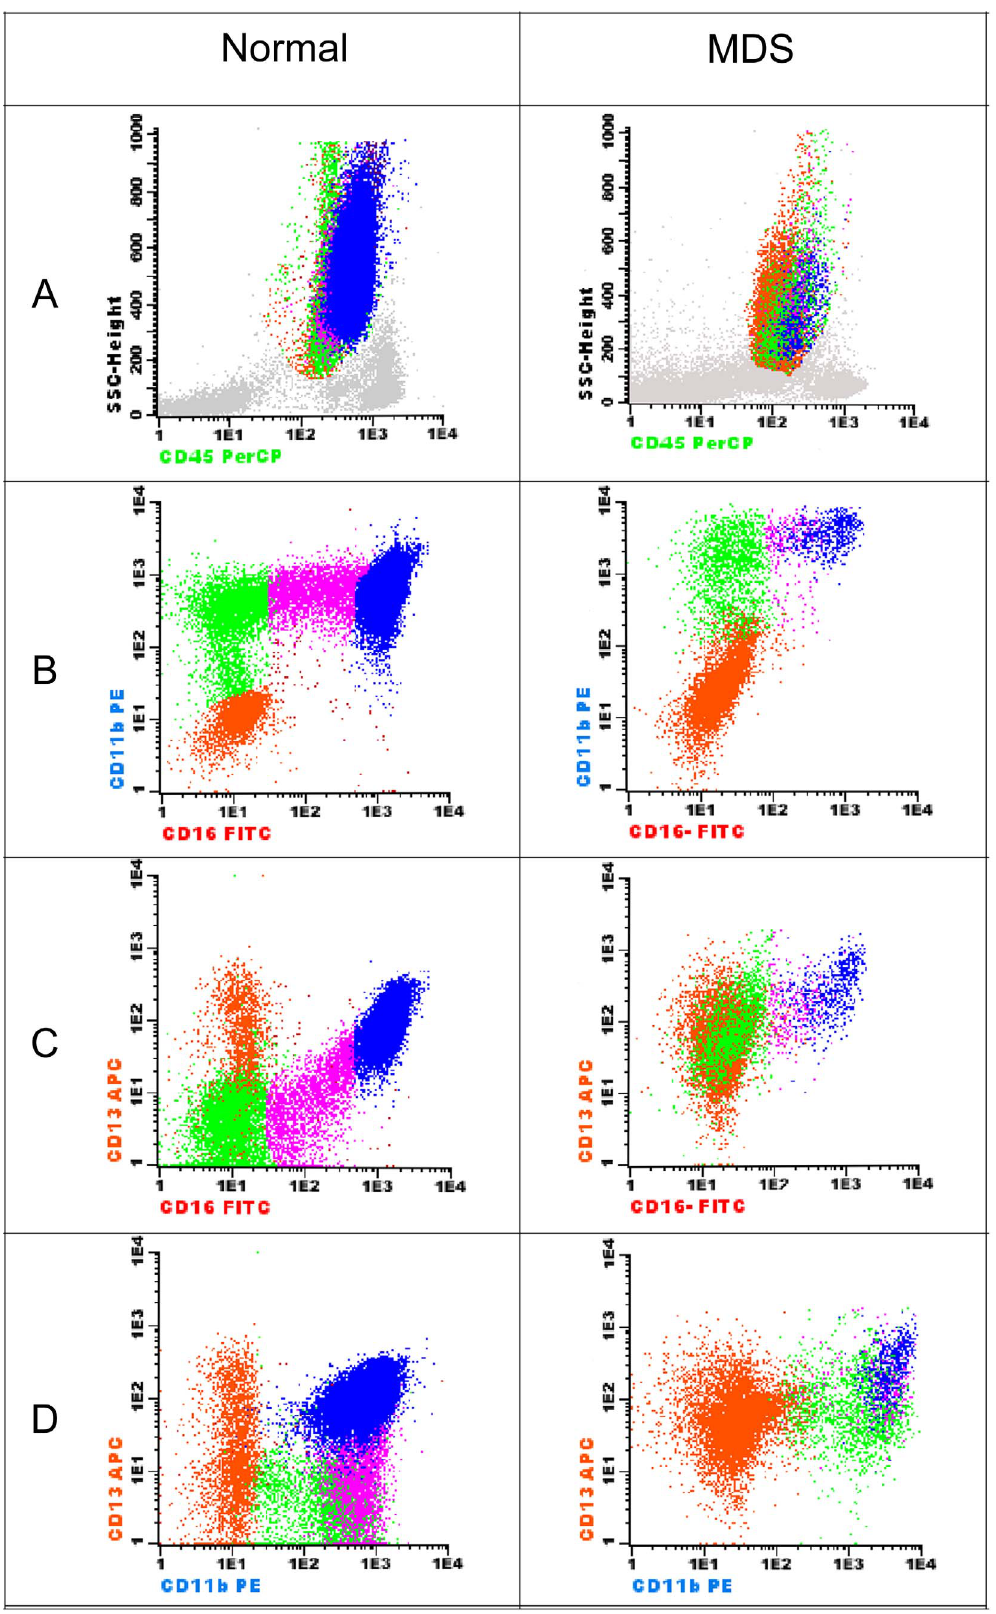
Figure 1. Detection of abnormalities in the granulocytic maturation: plots found in a normal BM on the left and those in a case of RCMD on the right (combination: CD16/CD11b/CD45/CD13). The granulocytic population was selected on the SSC/CD45 plot (A). The four